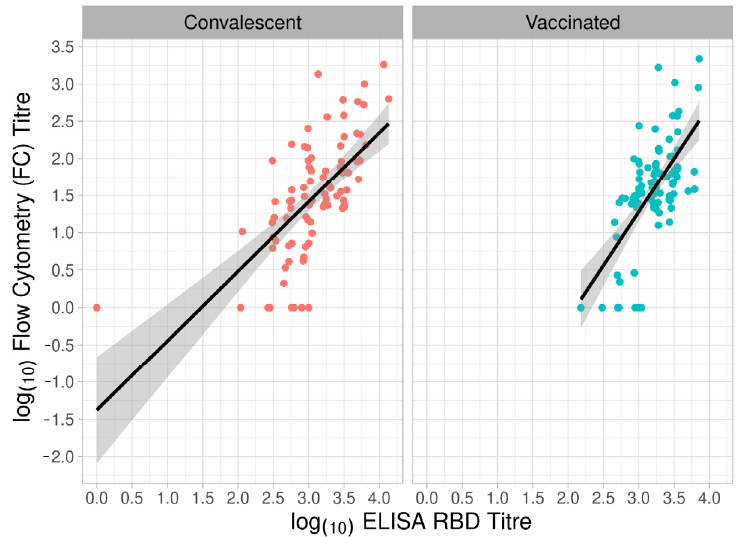
Figure 9. Log10 transformed values of titres obtained from ELISA RBD and FC. Different colour points indicate convalescent (red) and vaccinated (blue) participants. The best-fit linear regression line with the corresponding confidence interval is presented as a black line with a grey band.